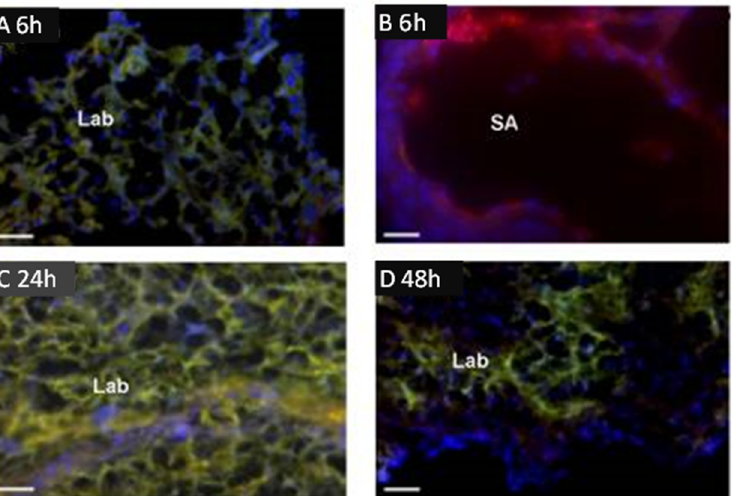
Figure 1. Binding of fluorescent dye-labeled CNKGLRNK to spiral arteries (SA) and labyrinth (Lab) of rodent placenta. Placentas from pregnant C57BL/6J mice collected at E18.5 following tail vein injection of Rh-CNKGLRNK (red)-decorated liposomes composed of NBD-labelled lipids (green) 6 ( A , B ), 24 ( C ), and 48 h ( D ) prior to tissue harvest. Yellow, co-localization of peptide (red) and lipid (green) fluorescence. Blue, DAPI (nuclei). Scale bars = 50 µM. Modified from [49].